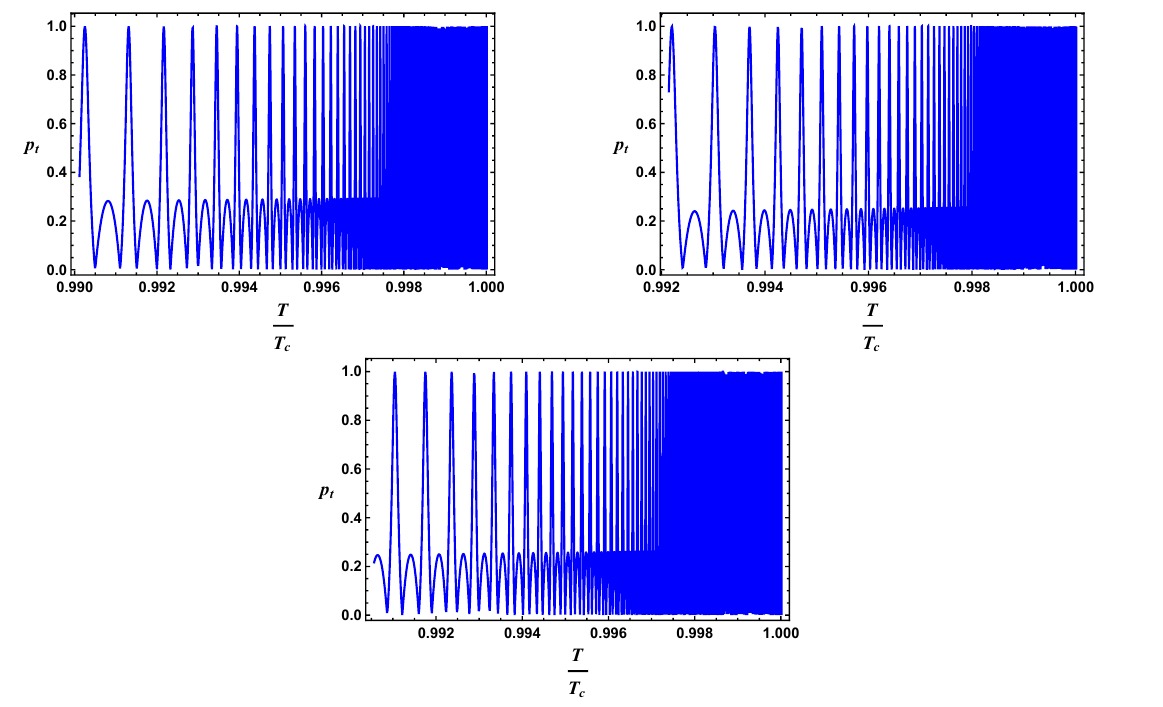
Figure 13 . The Kasner exponent p t after inversion as a function of the temperature in various configuration of the massive gravity. Notice that the accumulation of the oscillations near the critical temperature T c is described by the analytic expression (4.5) for d 3 which is plotted numerically in figure 6. They are for κ/µ = 1